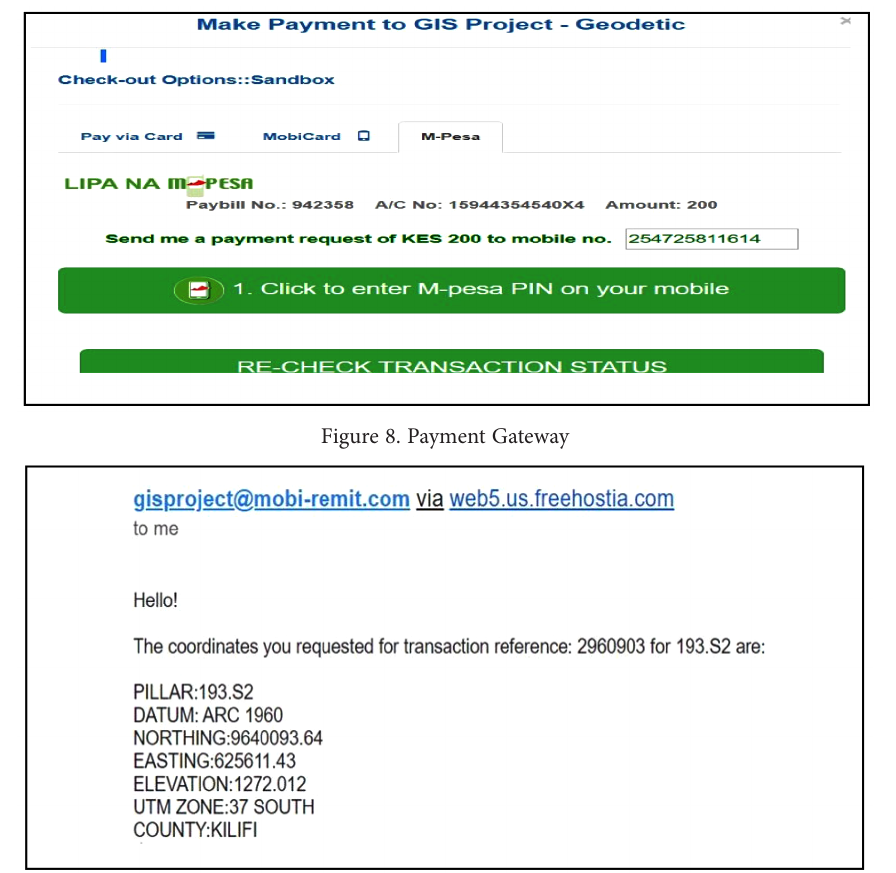
Figure 9. Remission of coordinates